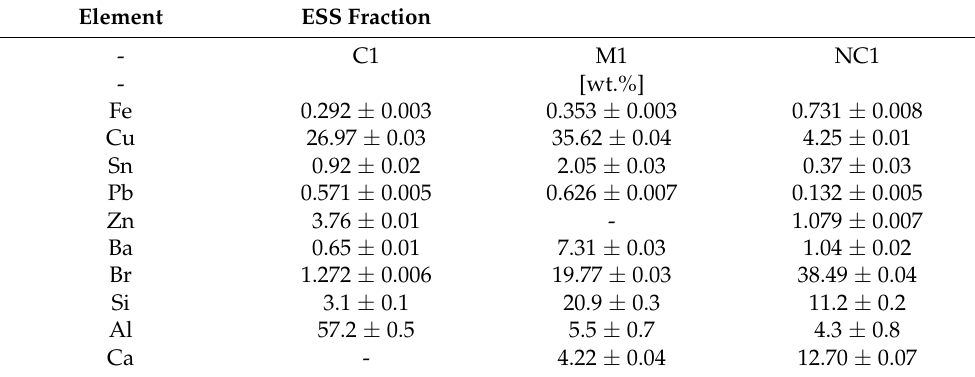
Table 4. Chemical composition of fractions C1, M1, and NC1.